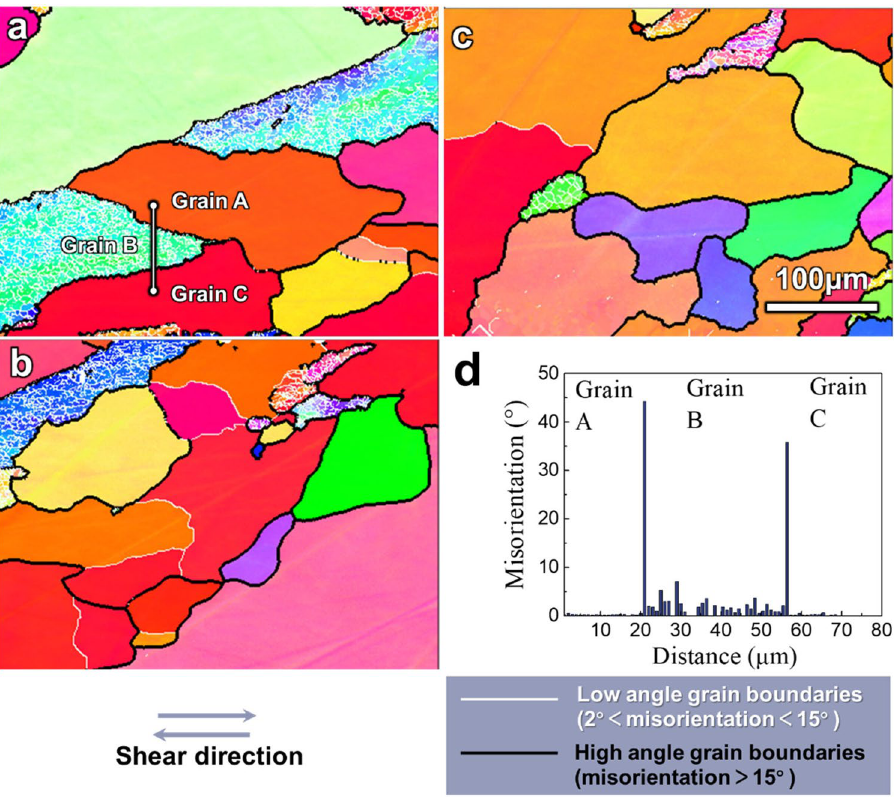
Figure 3. EBSD IPF maps from inner ( a ), middle ( b ) and outer ( c ) regions of the 5N Al processed by t -HPS to a rotation angle of π/6, and ( d ) the misorientation changes from grain A to C across B as shown in ( a ). The scale bar is the same in ( a–c ).